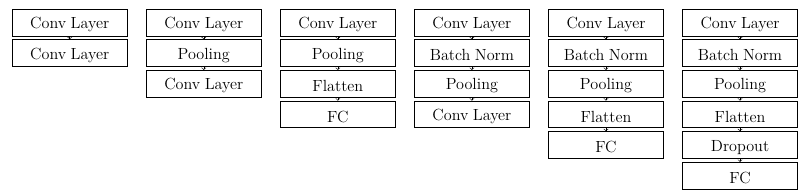
Figure 6. Possible permutations of layers after a convolutional layer.